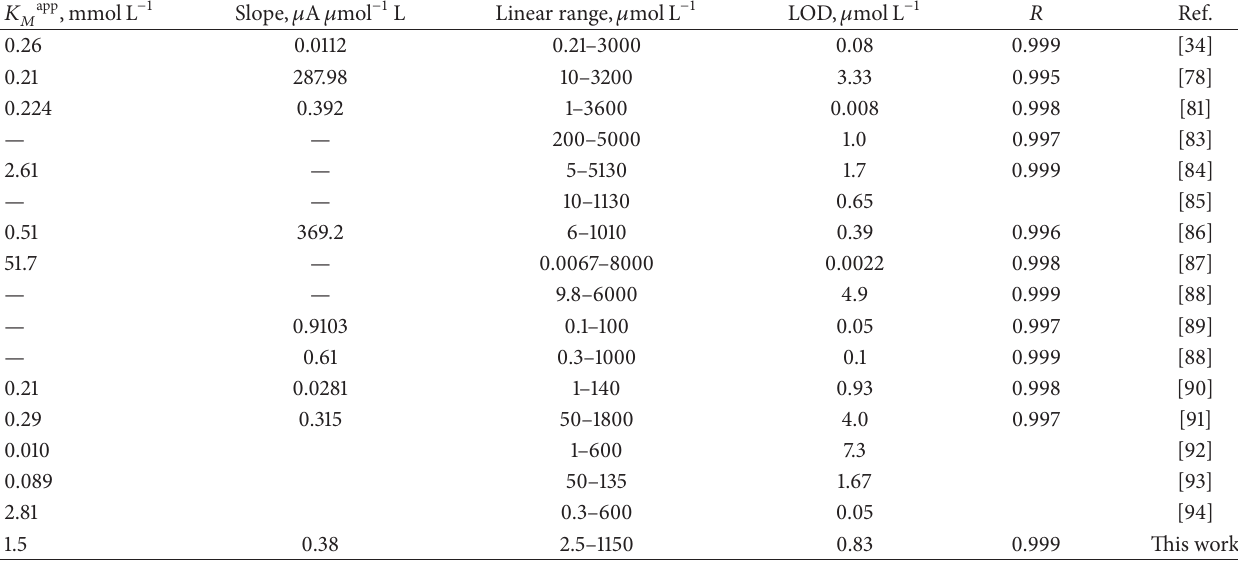
Table 6: Comparison of analytical and kinetic parameters for H 2 O 2 detection for different redox protein modified electrodes using H 2 O 2 as